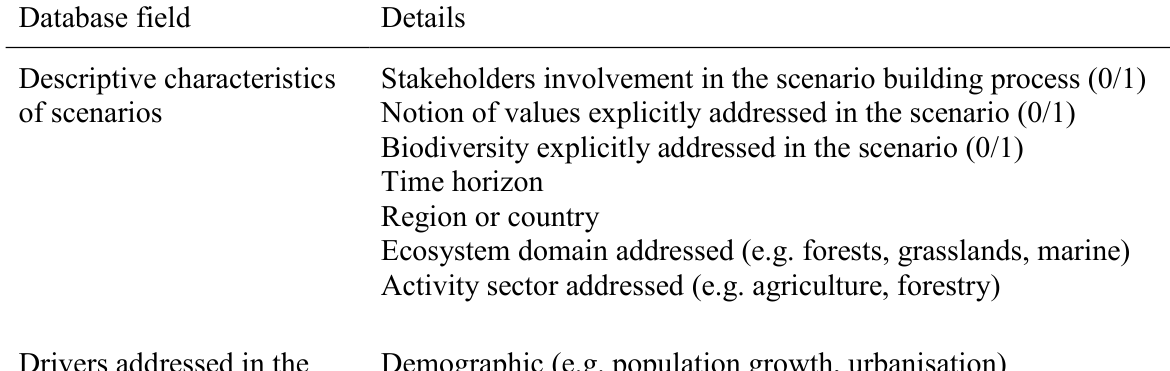
Table A2.3: Information extracted from the selected studies for each